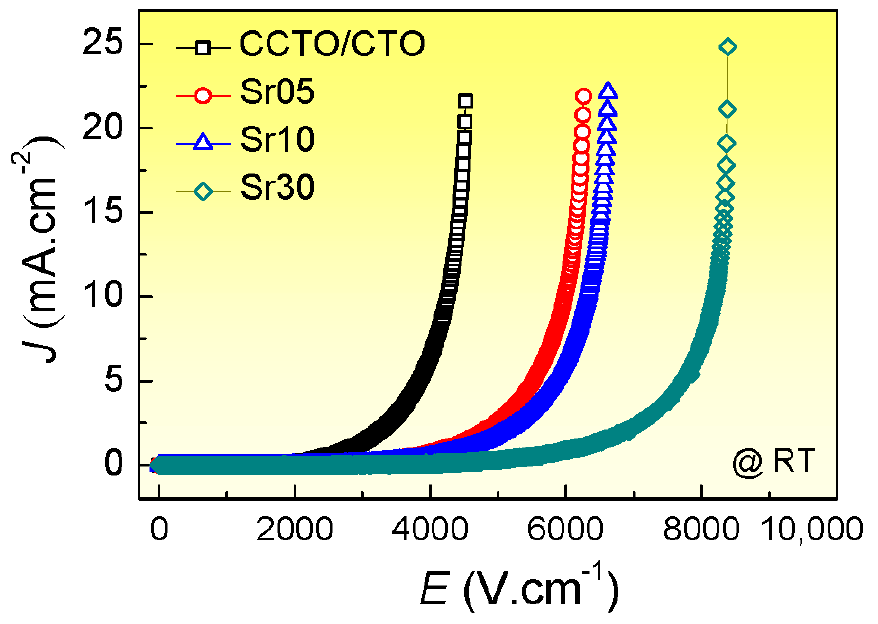
Figure 8. Nonlinear J-E characteristics at ∼ 25 °C of all composite samples.